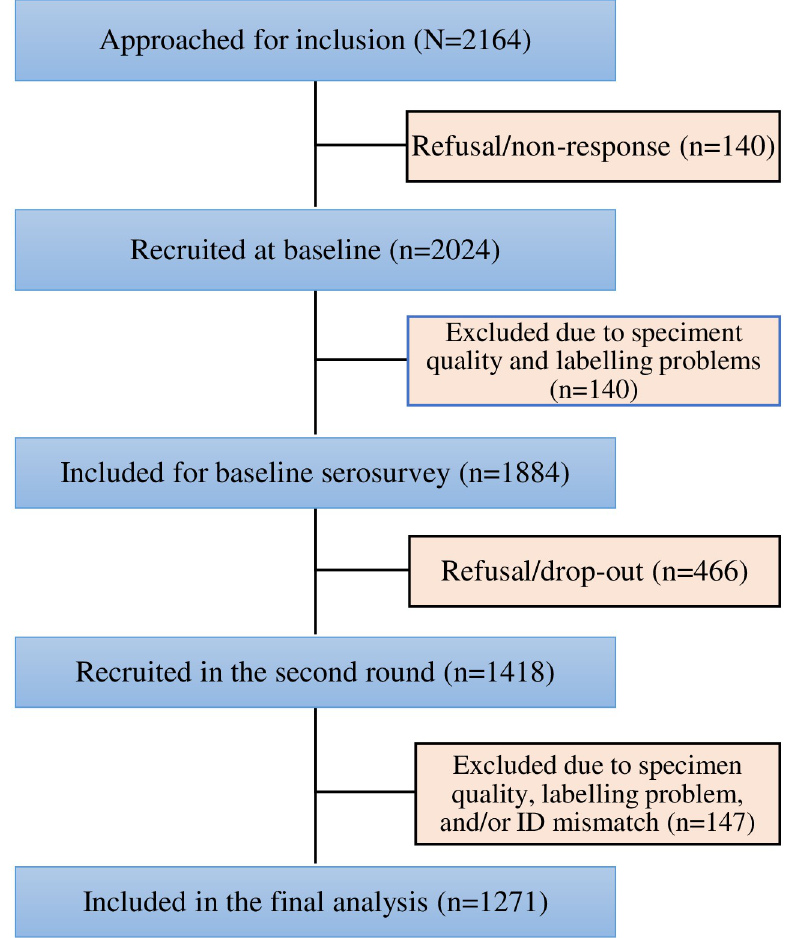
Fig 2. Consort diagram representing cohort description for points of inclusion and exclusion (n = number of students at each step). The mean ( ± SD) age of the participants at baseline was 15.8 (2.6) years, ranging from 10 to 27 years; 1116 (59.2%) of them were in the age group of 15 to 18 years. Females accounted for 1033 (54.8%) of the participants. The majority of the students, 1740 (92.4%), lived in a family size of three or more per household. Mask use and physical distance practices were low among the study participants. There are no marked differences in background characteristics between the first and second rounds of the students (Table 1).